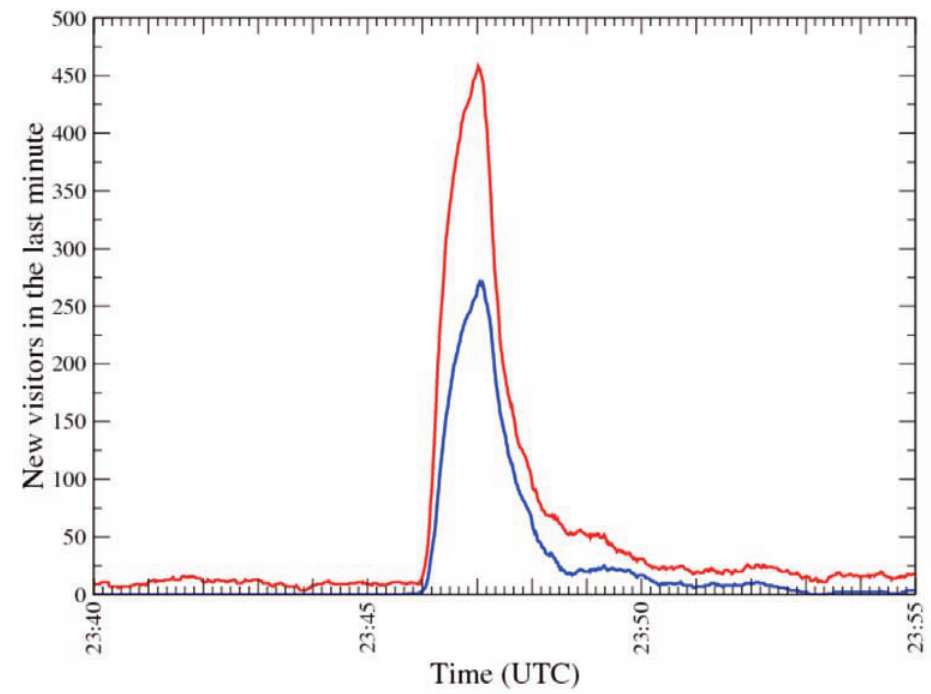
Figure 4. The mention of the EMSC website during a television program in Spain on March 21, 2010, led to a website traffic surge that was not related to an earthquake. The blue curve represents the website visitors originating from the Spanish Google search engine. They represent about 50% of the website visitors, which is a significantly higher fraction that what was observed during a website surge as a result of an earthquake, which is typically less than